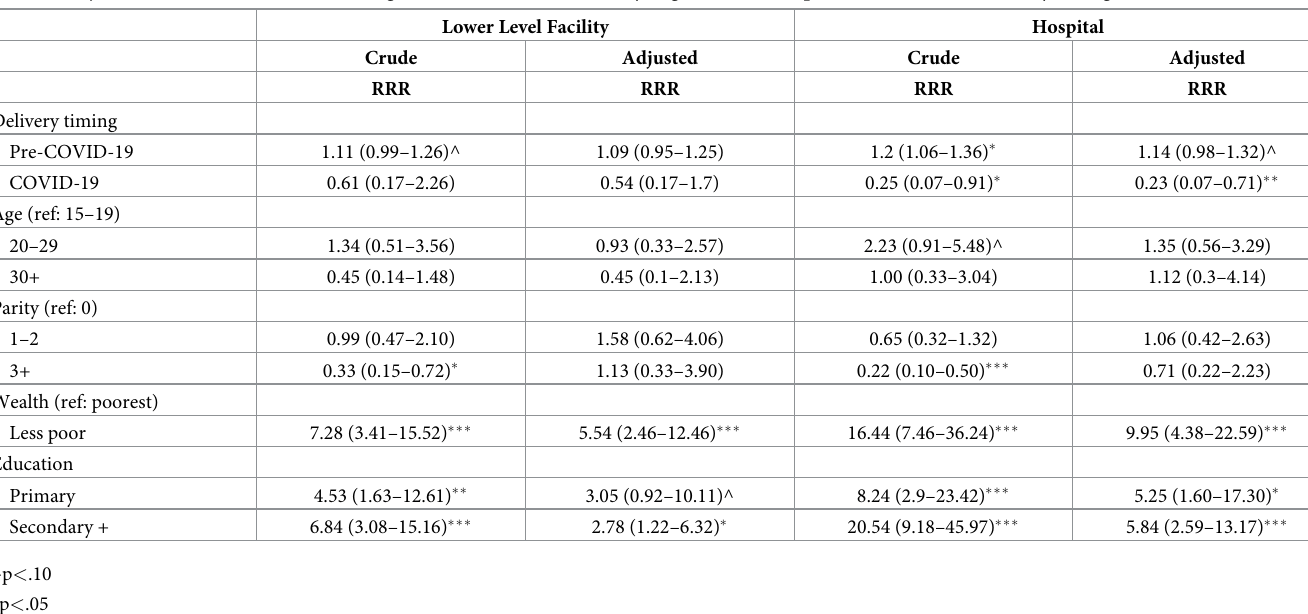
Table 3. Adjusted relative risk ratio of delivering in a lower-level health facility or government hospital relative to home delivery among women